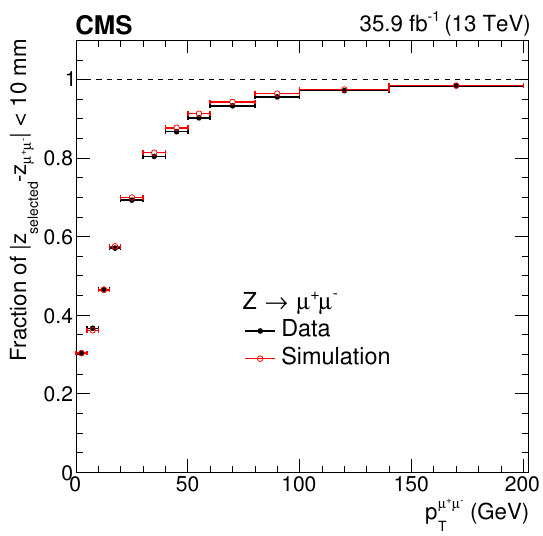
Figure 3 . Validation of the H ! (cid:13)(cid:13) vertex identi(cid:12)cation algorithm on Z ! (cid:22) + (cid:22) (cid:0) events omitting the muon tracks. Simulated events are weighted to match the distributions of pileup and location of primary vertices in